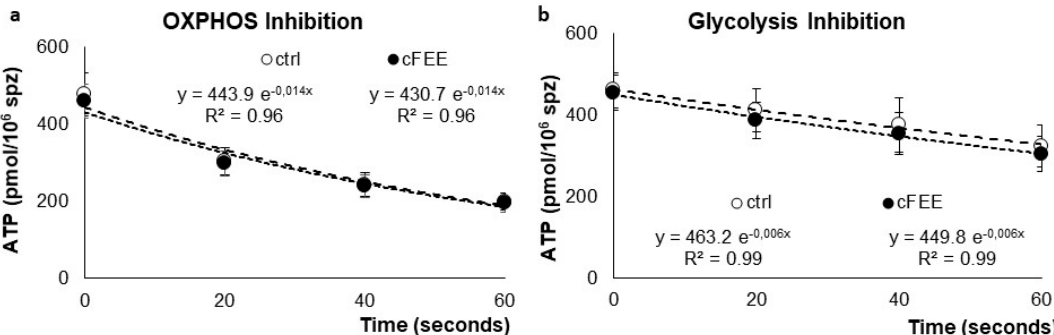
Figure 2. Average ATP concentrations in pmol/million sperm at different times after inhibition of ( a ) OXPHOS by oligomycin and ( b ) glycolysis by iodoacetate in donor sperm previously incubated in control medium (white circles) or in medium supplemented with cFEE (black circles).